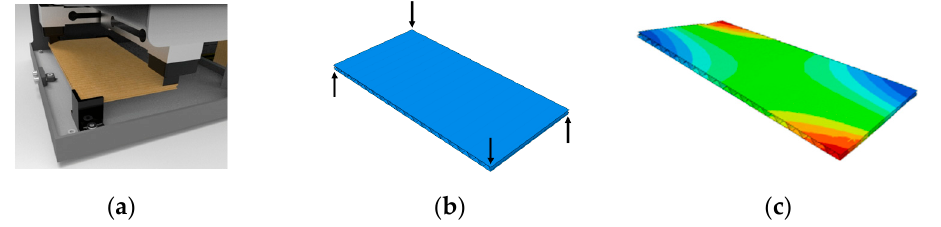
Figure 3. The shear stiffness testing: ( a ) cardboard testing device; ( b ) loaded sample; ( c ) deformed sample.